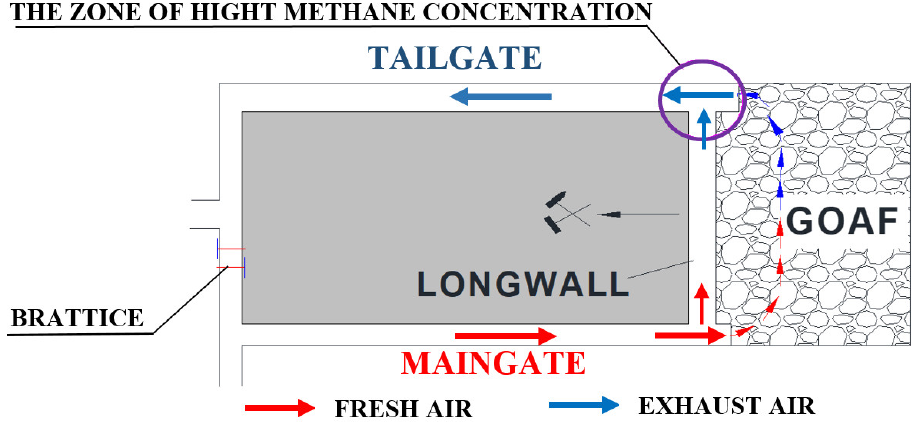
Figure 2. Diagram of the “U-type” ventilation system from the borders with an indicated area of methane concentration increase.